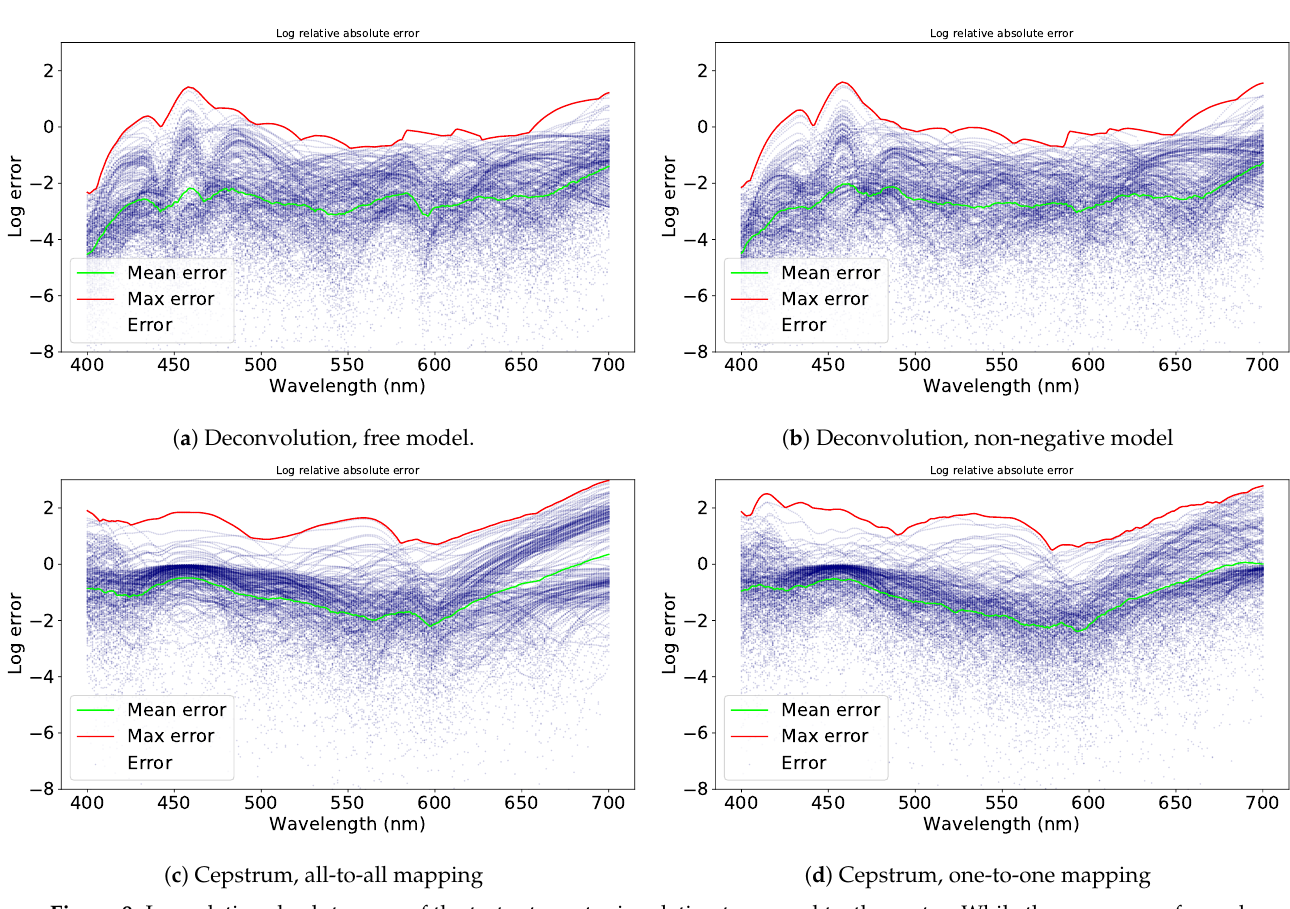
Figure 9. Log relative absolute error of the test set spectra in relation to ground truth spectra. While the mean error for each wavelength is generally low, especially for the deconvolution models, the maximum error can be quite high. Table 3. Median of ∆ E 00 between estimated and ground truth spectra for camera, illuminant, method, and model